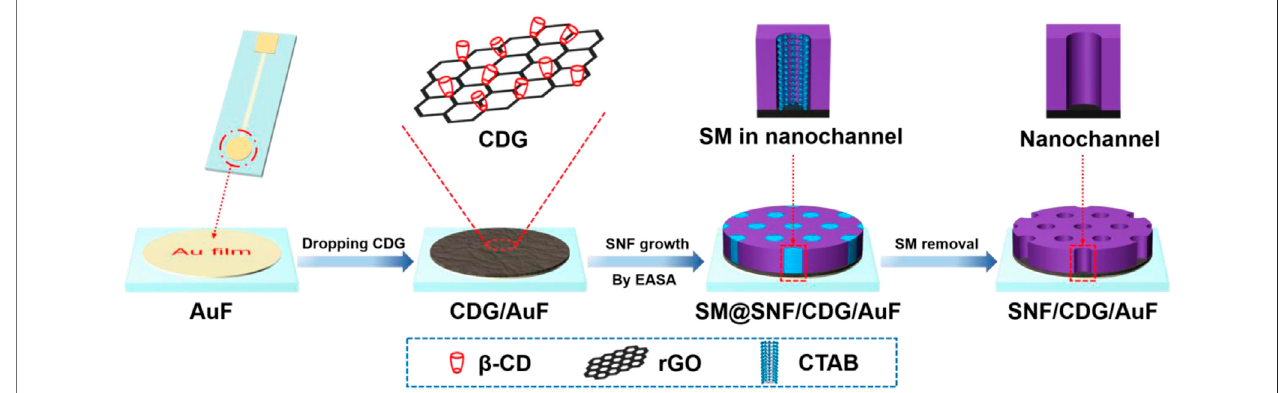
FIGURE 1 | Illustration of facile preparation of SNF/CDG/AuF by EASA method using CDG as nanoadhesive.